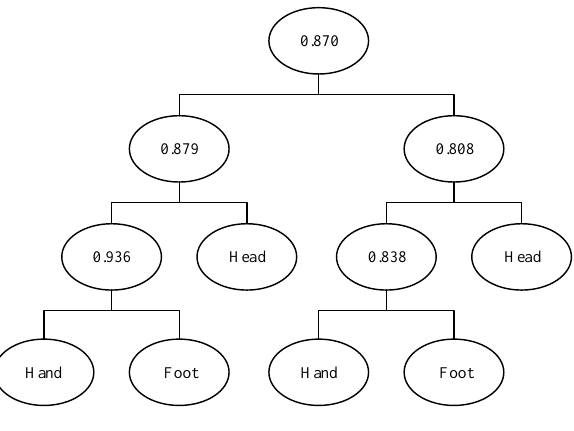
Figure 4. Random forest training